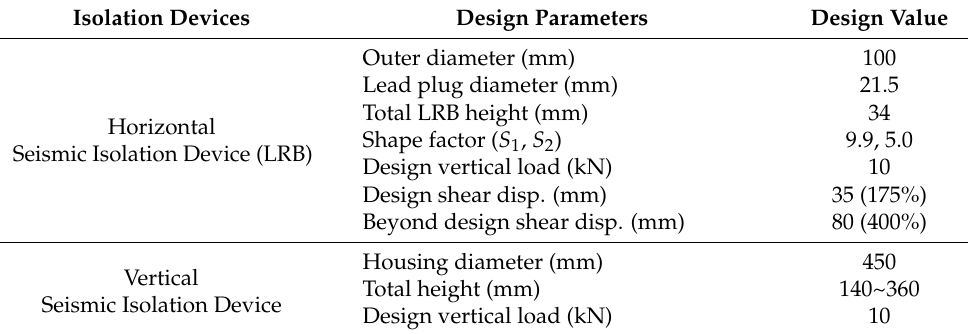
Table 1. Summary of 3D seismic isolator design parameters [16].